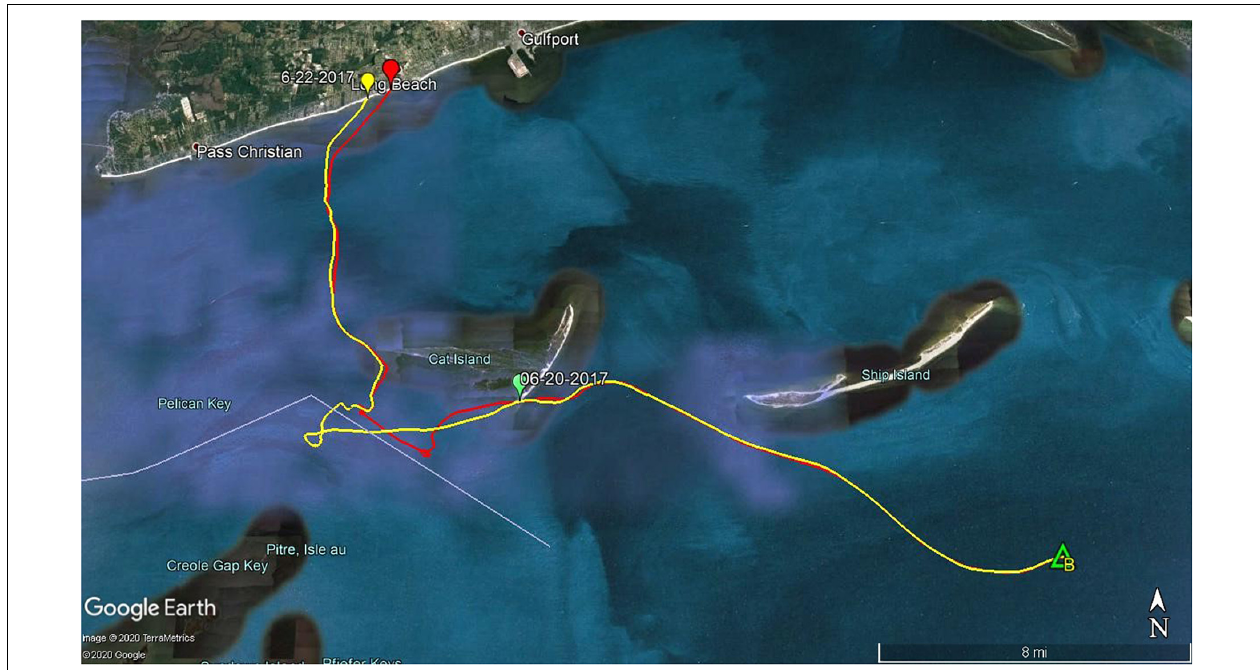
FIGURE 12 | Effigy tracks from 25 June 2017 site B deployment. Two effigies originally beached on Cat Island within 24 h of deployment but refloated due to Tropical Storm Cindy and both beached a second time, within an hour of each other, on the mainland in Long Beach,